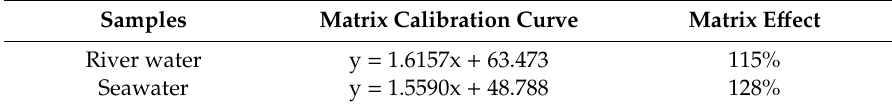
Table 2. The matrix calibration curve and matrix e ff ect of river water and seawater.